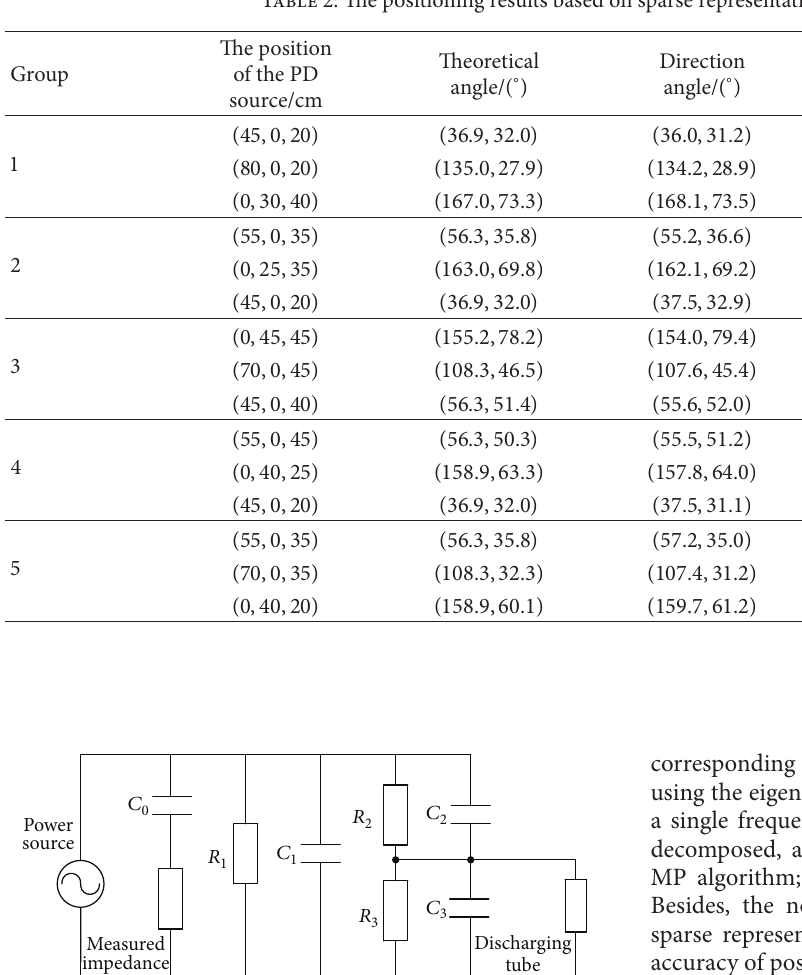
Table 2: The positioning results based on sparse representation of the eigenvector.